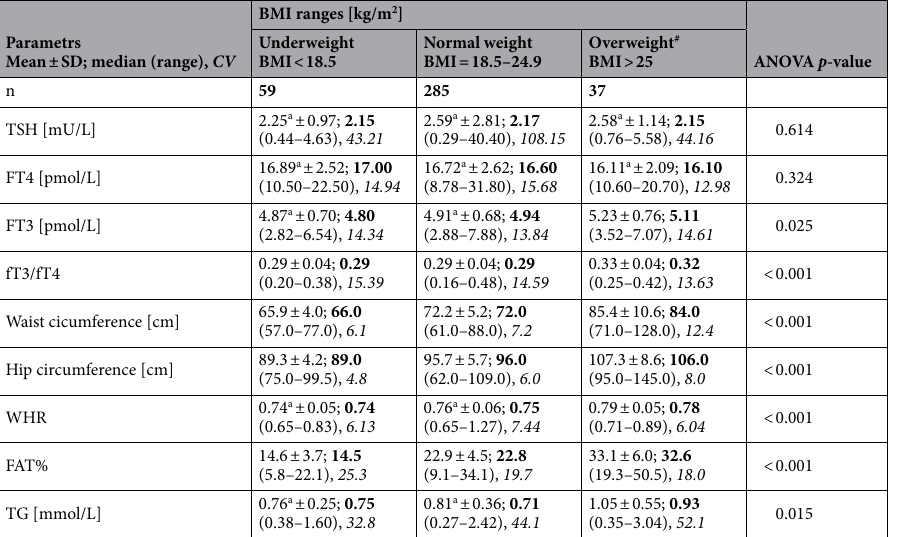
with each BMI range. For consecutive BMI ranges differences (p < 0.05) were found in the associations between the serum TG concentrations and the thyroid hormones and anthropometric measurements. In underweight subjects a negative correlation was established between TG vs fT4 and TG vs fT3 (r = − 0.306, − 0.258, respec- tively), in normal-weight subjects a positive correlation was established between TG vs TSH, TG vs fT3, TG vs fT3/fT4, TG vs FAT%, (r = 0.181, 0.139, 0.138, 0.117, respectively), while in the overweight range there was no association between these parameters. The differences between the correlations of fT3 and TG concentrations within the BMI ranges (underweight, normal and overweight) are presented on the graph in Fig. 1. The differences in the thyroid and anthropometric parameters and serum TG measured in underweight, normal-weight and overweight subjects within the Normal vs High TSH groups (TSH ranges 0.4 to 2.5 mU/L vs > 2.5 mU/L) are presented on the graph in Fig. 2. An increase in the fT3/fT4 ratios (p < 0.05) found in the underweight vs overweight subjects and the normal- weight vs overweight subjects occurred within the normal TSH range (0.4 to 2.5 mU/L). An increase in anthropo- metric parameters found in the underweight vs normal weight vs obese subjects was observed within both normal and high TSH ranges. No association was established between the TSH range and serum TG concentrations in underweight, normal-weight and overweight subjects.